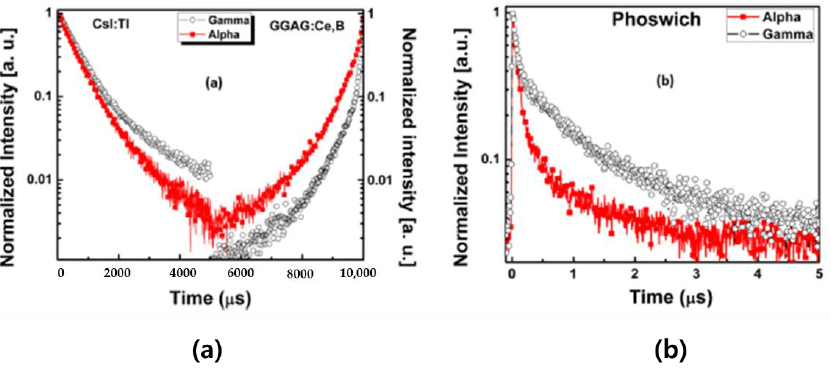
Figure 29. ( a )The scheme and ( b ) actual setup of the Phoswich detector [62].